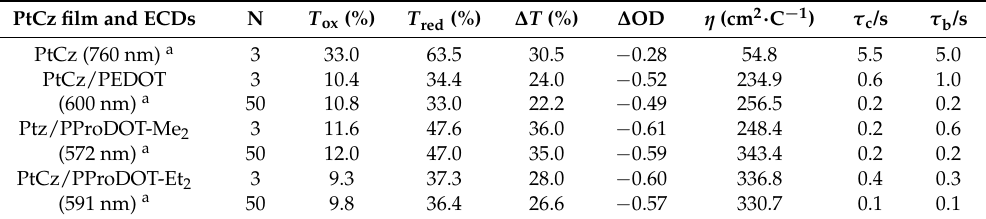
Table 3. Optical and electrochemical properties investigated at the selected applied wavelength for PtCz film and ECDs.